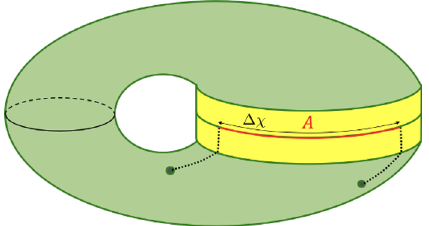
Figure 26 . We consider a non-trivial configuration of quantum extremal surfaces in the connected